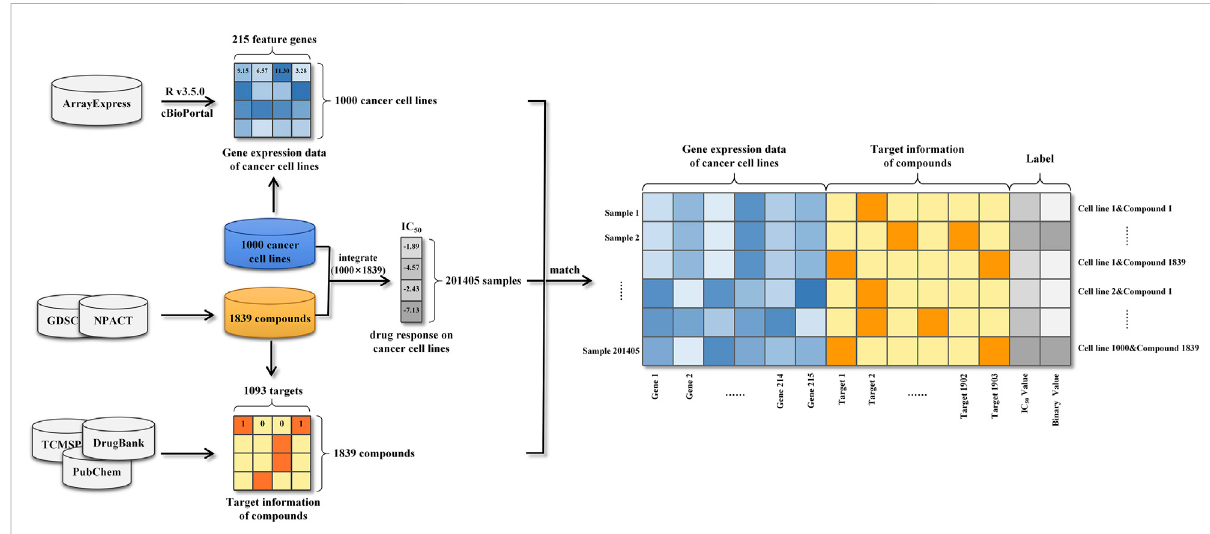
FIGURE 1 Schematic illustration of the construction of our modeling dataset.